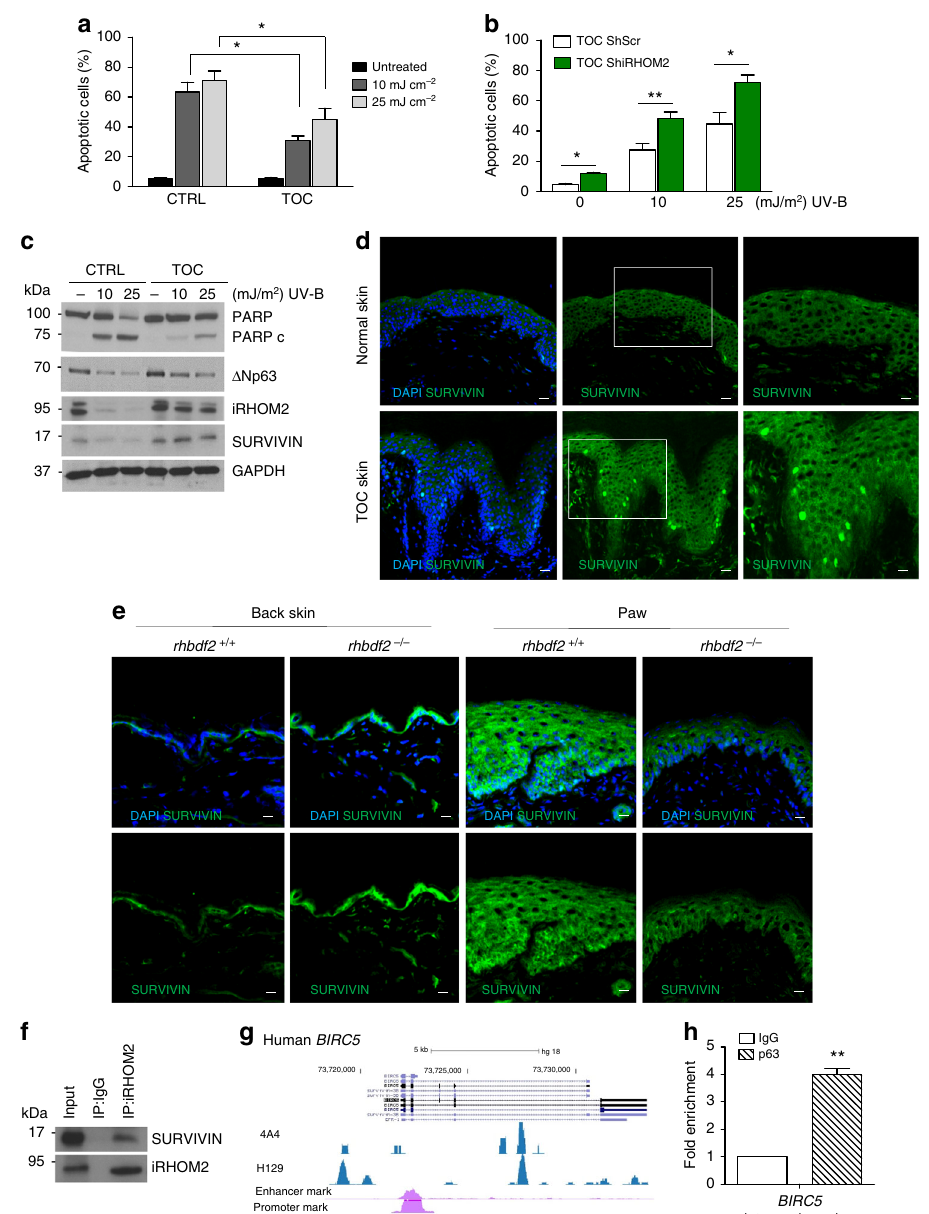
Fig. 4 iRHOM2 – p63 axis regulates apoptosis in keratinocytes by modulating SURVIVIN. a Percentage of apoptotic cells was quanti fi ed by using fl ow cytometric analysis of annexin-V-positive populations in control (CTRL) and TOC keratinocytes after 24 h of UV-B irradiation (10 or 25 mJ/cm 2 ). Data represent means and SEM of four experiments. Statistical analysis was performed comparing TOC keratinocytes treated with 10 or 25 mJ/cm 2 and CTRL cells treated at the same doses using Student ’ s two-tailed t -test (* p < 0.05). b Percentage of apoptotic cells was quanti fi ed by using fl ow cytometric analysis of annexin-V-positive populations in Sh Scr and Sh iRHOM2-transfected TOC keratinocytes irradiated with 10 or 25 mJ/cm 2 for 24 h. Data represent mean with SEM of fi ve independent experiments. For statistical evaluation Student ’ s two-tailed t test was used (* p < 0.05, ** p < 0.01). c Immunoblotting for PARP, cleaved PARP (PARPc), Δ Np63, iRHOM2 and SURVIVIN in UVB irradiated CTRL and TOC keratinocytes with 10 or 25 mJ/cm 2 UV-B treatment. GAPDH is used as a loading control. d Representative confocal microscopy images from immunostaining of SURVIVIN in normal and TOC skin. DAPI (blue) is used as a nuclear stain. Scale bar: 20 µ m. e Immunostaining of SURVIVIN was performed in back skin and fore-paw sections of rhbdf2 + / + and rhbdf2 − / − mice by confocal microscopy. DAPI (blue) is used as a nuclear stain. Scale bar: 20 µ m. f CTRL keratinocyte lysates were immunoprecipitated using an anti-iRHOM2 antibody and immunoblotted with anti-SURVIVIN antibody. g Screenshot of the UCSC genome browser from ChIP-seq analysis of normal human primary keratinocytes with two different antibodies (4A4, pan-p63 and H129, α -speci fi c) for BIRC5, gene encoding SURVIVIN. The ChIP-seq study was previously reported. h Chromatin immunoprecipitation in control keratinocytes (CTRL) with anti-pan p63 (H137) and anti-IgG antibodies followed by ChIP-qPCR analysis showed that p63 binds to the BIRC5 intergenic region. Error bars represent SEM of three independent experiments. For statistical evaluation Student ’ s two-tailed t test was used (** p <